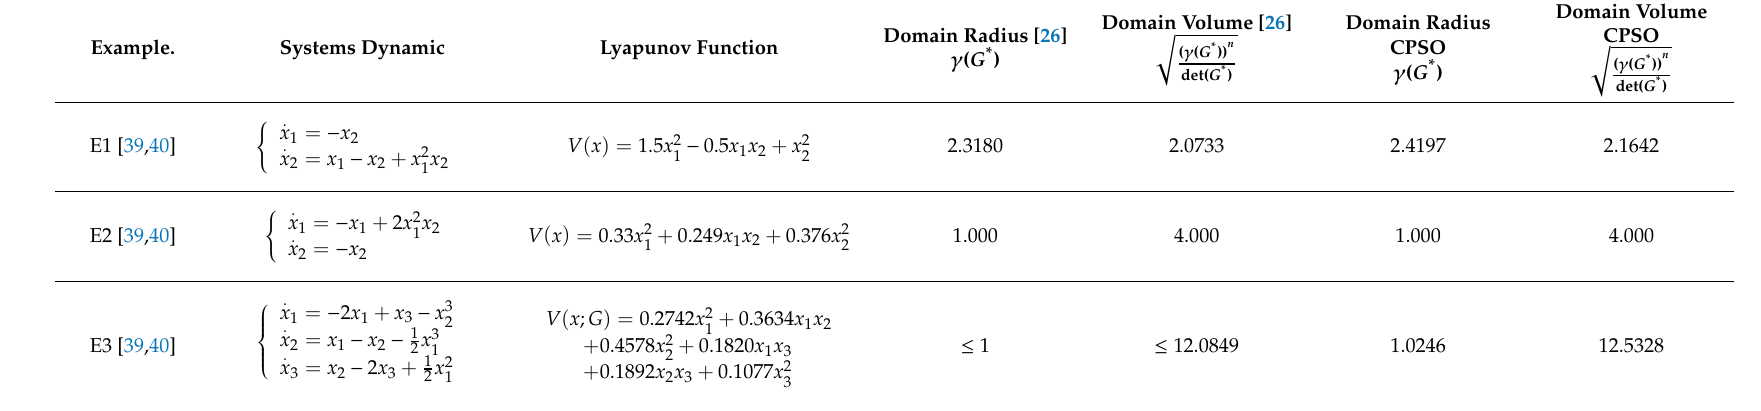
Table 2. Comparative analysis with benchmark nonlinear systems using a defined quadratic LF as described in [39,40].